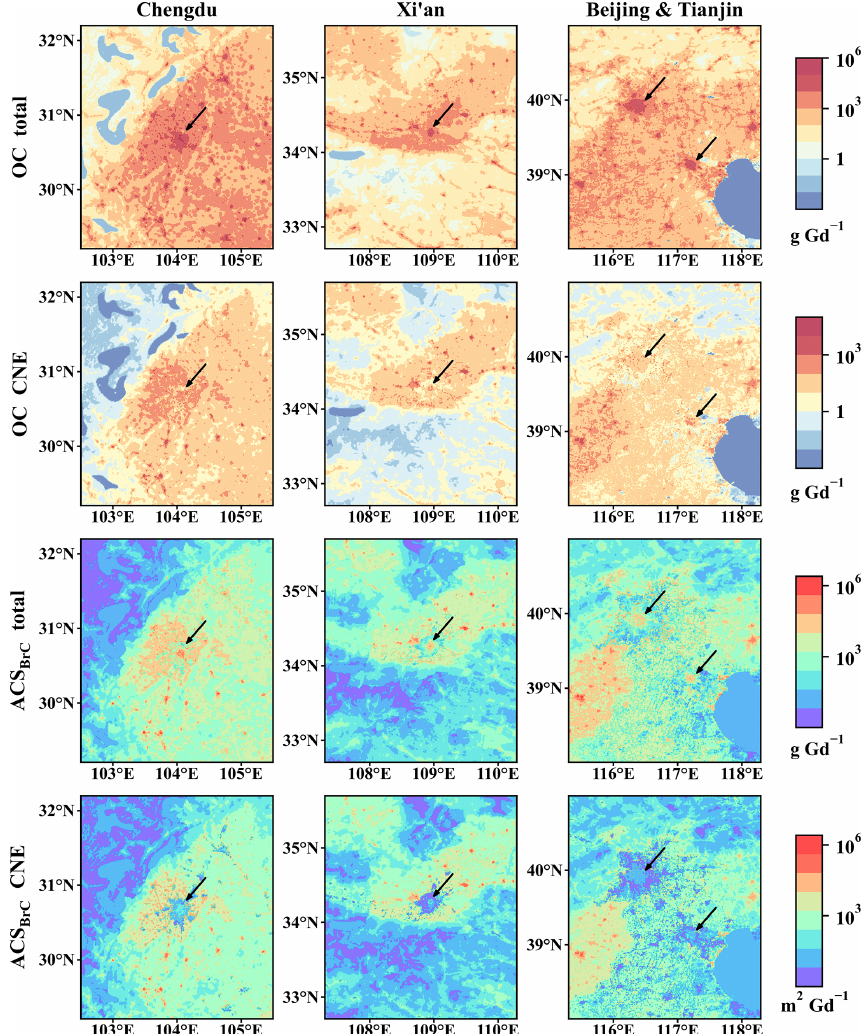
Figure 8. Differences in OC (top two rows) and ACS BrC (bottom two rows) emission distributions in urban and rural regions in Chengdu (core city in the Sichuan Basin), Xi’an (core city on the Guanzhong Plain), and Beijing and Tianjin (core cities on the North China Plain). The first and second rows show the total OC emissions in 2018 and during CNE, respectively. The third and fourth rows show the ACS BrC emissions in 2018 and during CNE, respectively. The arrows point to the city centers. The color bars show the emission in each grid (Gd) for OC and ACS BrC